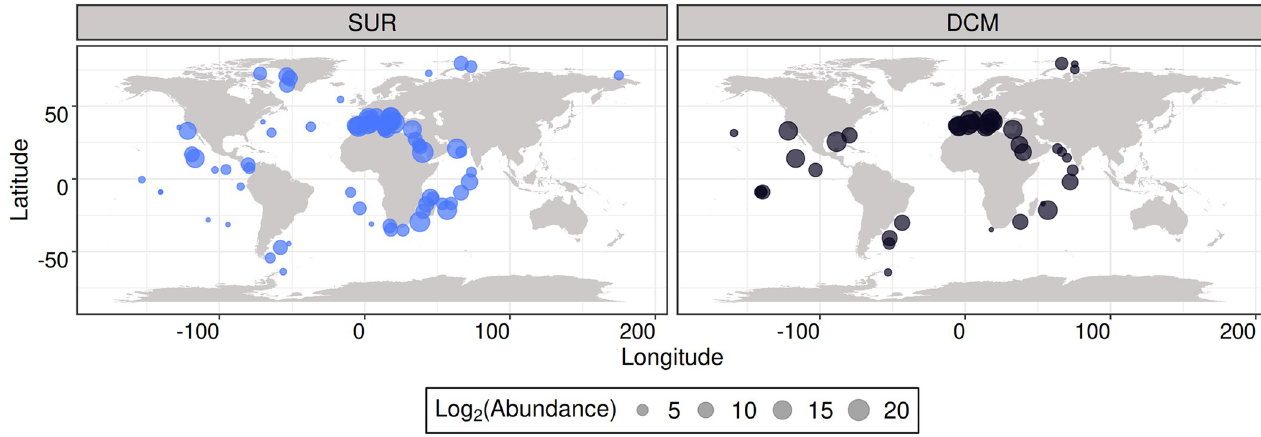
Fig 1. Global patterns of Chaetoceros genus distribution based on Tara Oceans metabarcoding data of V9 18S rDNA. AU : AbbreviationlistshavebeencompiledforthoseusedinFigs 1 to 5 and 7 : Pleaseverifythatallentriesarecorrect : The 4 eukaryotic-enriched size fractions 0.8–5 μ m, 5–20 μ m, 20–180 μ m, and 180–2,000 μ m were pooled for a total of n = 2,739 OTU barcodes in SUR and DCM depths (see S1 Data for raw values). The basemap was generated from the Natural Earth data (http://www.naturalearthdata.com/downloads/50m-physical-vectors/); Natural Earth—All maps are public domain (http://www.naturalearthdata.com/about/terms-of-use/). DCM, deep-chlorophyll maximum; OTU, operational taxonomic unit; SUR,